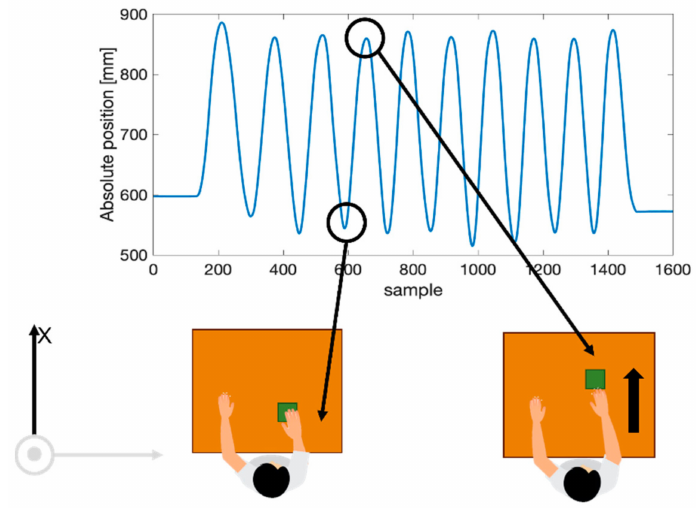
Figure 7. Example of the movement of the object along the x-axis. The highlighted minimum point represents the instant of the minimal distance of the object from the subject, while the highlighted maximum point represents the instant of the maximal distance from the